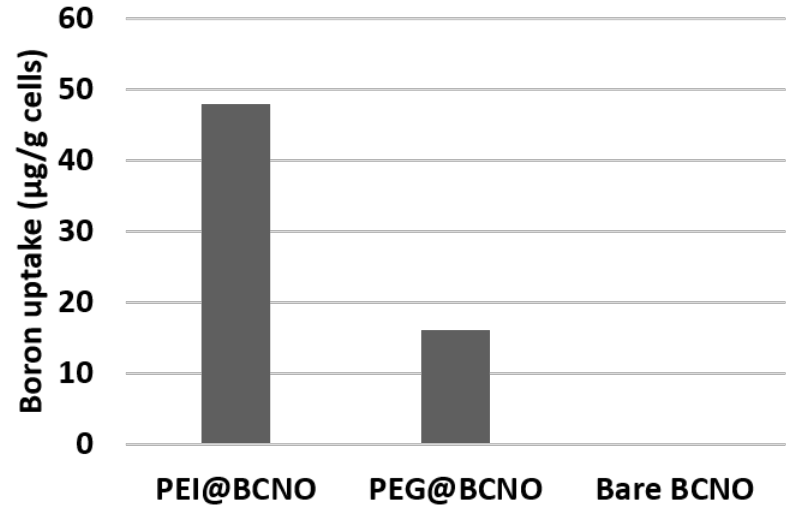
Figure 7. ICP-MS cell uptake of PEI@BCNO, PEG@BCNO and bare BCNO with ALTS1C1 cells.